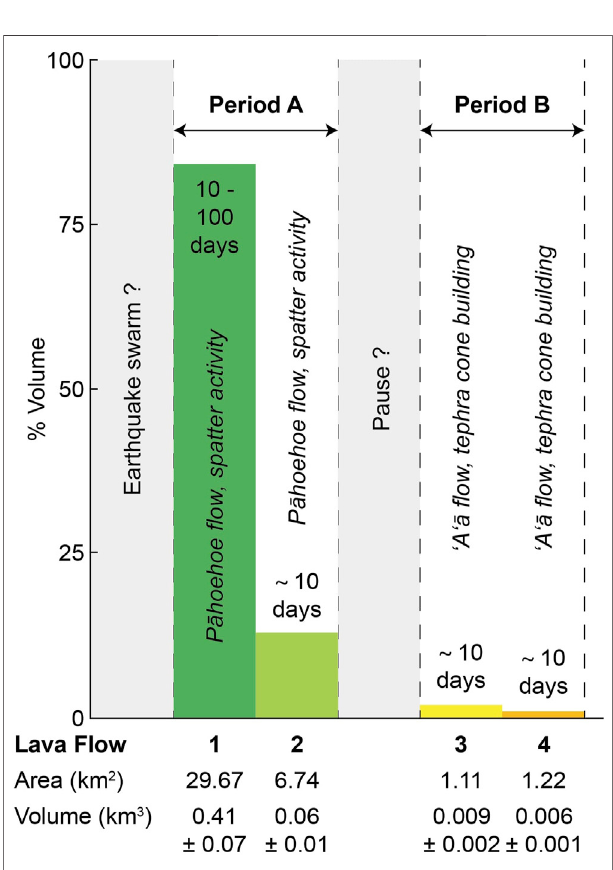
FIGURE 8 | Sequence of eruptive episodes versus volume emitted. The eruption is divided in two periods and the emission of the four lava fl ows.